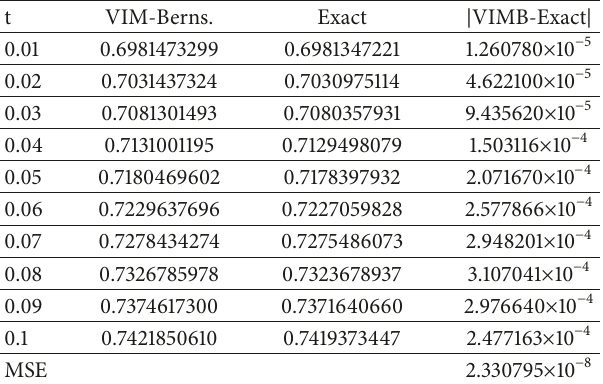
Table4:Theabsoluteandmeansquareerrorsusingy 3 for(28)when n=m=2 and 𝑥 = 2 .